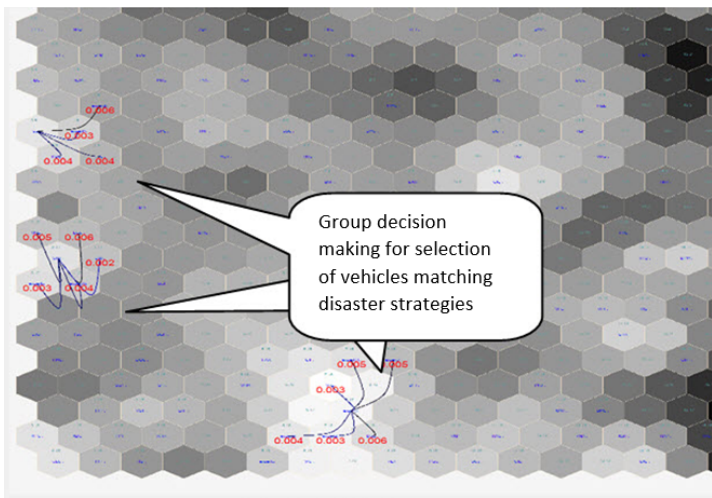
Figure 4. The SOM map results in matching emergency strategies for emergency case study in